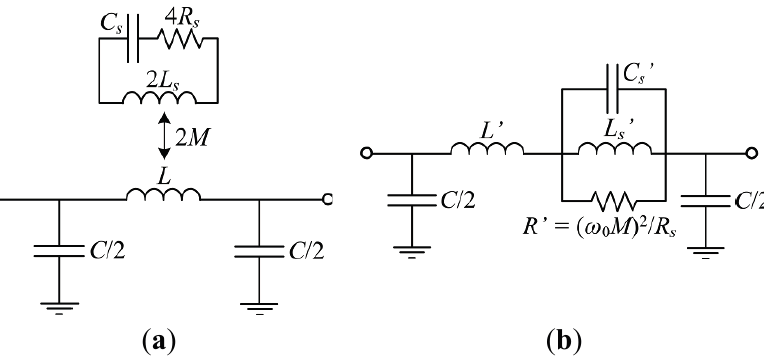
Figure 5. Lossy angular-dependent equivalent circuit model of an S-SRR-loaded CPW. ( a ) Simplified model and ( b ) equivalent transformed model.